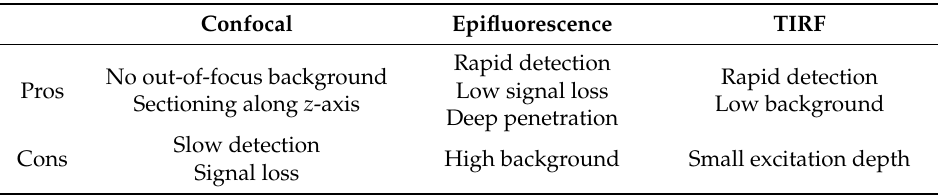
Table 1. Pros and cons of confocal, epifluorescence, and TIRF